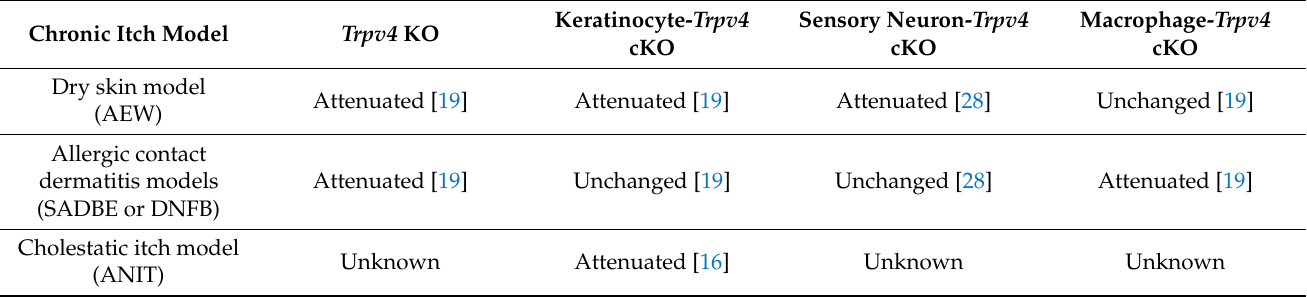
Table 2. Effects of global or conditional knockout of Trpv4 on experimental chronic itch behaviors. Chronic Itch